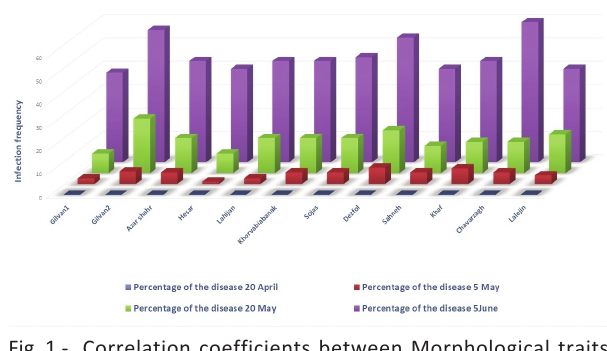
Table 11­ Correlation coefficients between physiological traits and resistance to rust ( Puccinia allii ) in Iranian garlic clones measured by Pearson's two­domain test